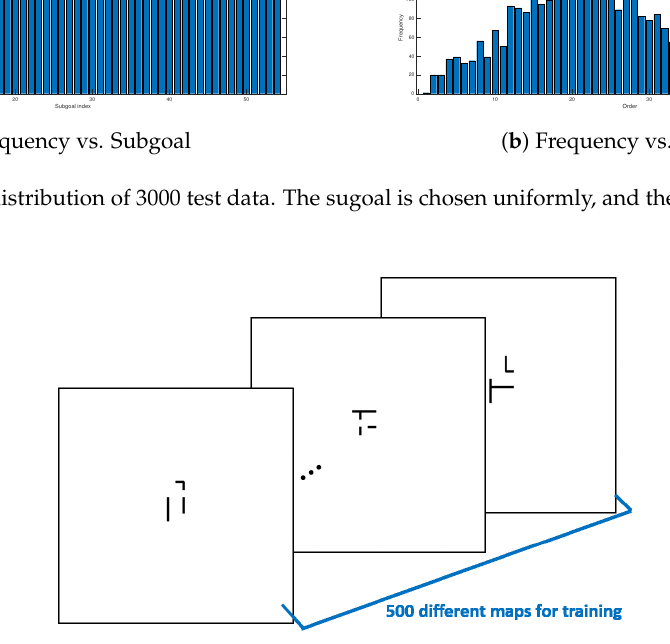
Figure 8. The training data for the transformation stage. The black areas represent different obstacles in each